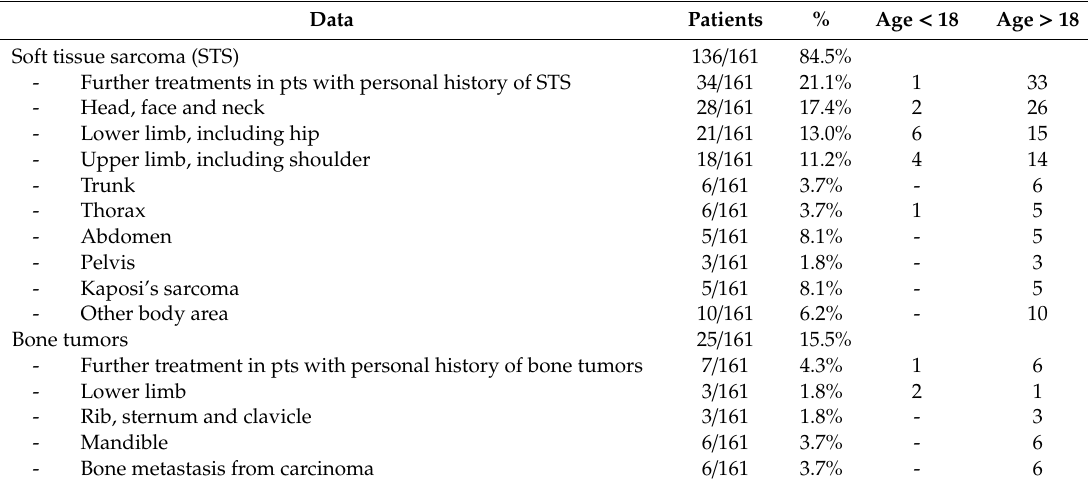
Table 2. Types and anatomical distribution of soft tissue sarcoma (STS) and bone tumors. Data Patients % Age < 18 Age > 18